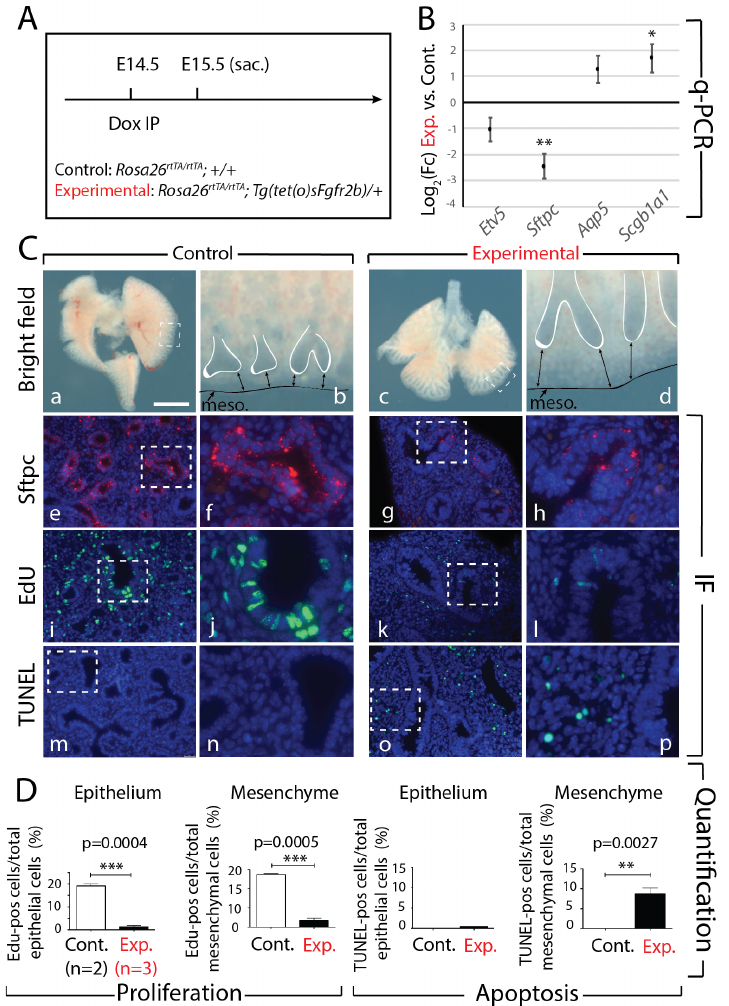
Figure 4. E ff ects of transient Fgfr2b signaling inhibition for 24 h in E14.5 lungs. ( A ) Experimental design: pregnant females carrying experimental and littermate control embryos were injected with a single Dox-IP and sacrificed 24 h later. ( B ) qPCR analysis showing downregulated expression of AT2 markers Etv5 (not significant) and Sftpc ( n = 3; ** p < 0.01), and upregulated expression of the AT1 marker Aqp5 (not significant), and the proximal epithelial marker Scgb1a1 ( n = 3; * p < 0.05). ( C ) Brightfield (a–d) and immunofluorescent (e–p) images of control and experimental lungs. Note the elongated epithelial tubes, reduced distal tip branching, and increased distance between tips and mesothelium (black arrows) in experimental lungs compared to controls (d vs. b). Staining for Sftpc shows a decrease in the epithelium of experimental lungs (h vs. f), confirming the qPCR expression data. Staining for EdU and TUNEL to assess proliferation and apoptosis, respectively, showed decreased proliferation in both the epithelial and mesenchymal compartments of experimental lungs compared to controls (l vs. j), while apoptosis was increased only in the mesenchyme of experimental lungs (p vs. n). (meso. = mesothelium). Scale bar: (a, c) 750 µ m, (b, d) 95 µ m, (e, g, i, k, m, o) 75 µ m, (f, h, j, l, n, p) 30 µ m. ( D ) Quantification of EdU and TUNEL expressions in the epithelial and mesenchymal compartments of experimental vs. control lungs. (** p -value < 0.01, *** p -value <